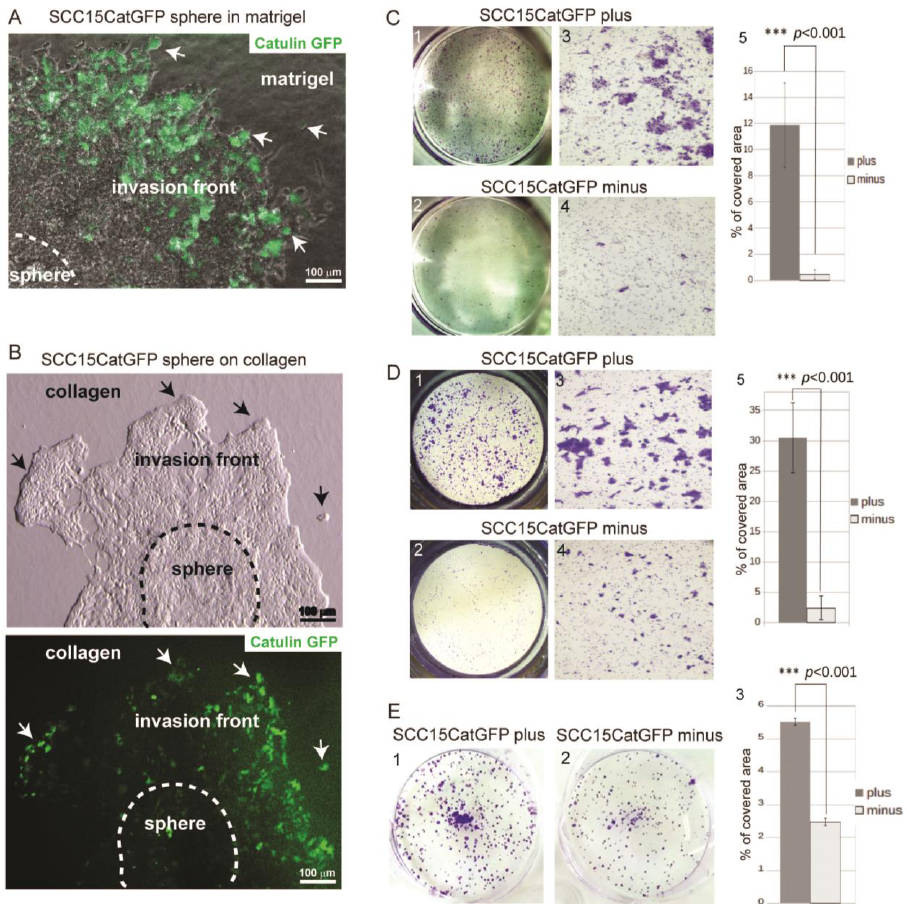
Figure 2. Migratory, invasive, and tumorigenic potential of the cells labeled with Catulin-GFP reporter system in vitro. ( A ) Sphere formed by SCC15CatGFP cells invading into Matrigel presented in a bright field and GFP fluorescence. Arrows indicate cells with the highest alpha-catulin (GFP fluorescence) expression at the invasion front. Scale bar: 100 µm. ( B ) Sphere formed by SCC15CatGFP cells placed on collagen presented in a bright field ( upper picture ) and GFP fluorescence ( lower picture ). Arrows indicate cells with the highest alpha-catulin (GFP fluorescence) expression at the invasion front. Scale bar: 100 µm. ( C ) Boyden chamber migration assays of the SCC15CatGFP plus and SCC15CatGFP minus populations. ( 1 , 2 ) Image of the entire insert. ( 3 , 4 ) Image of a randomly selected area at a higher magnification (4×). Cells were stained with crystal violet. ( 5 ) Quantification of the cells from both populations that migrated through the insert. *** statistical significance was assessed by t-test ( p < 0.001). Standard error bars are shown. ( D ) Boyden chamber Matrigel invasion assays of the SCC15CatGFP plus and SCC15CatGFP minus populations. ( 1 , 2 ) Image of the entire insert. ( 3 , 4 ) Image of a randomly selected area at a higher magnification (4×). Cells were stained with crystal violet. ( 5 ) Quantification of cells from both population that invaded through the insert covered with Matrigel. *** statistical significance was assessed by t-test ( p < 0.001). Standard error bars are shown. ( E ) Colony formation assays of the SCC15CatGFP plus ( 1 ) and SCC15CatGFP minus ( 2 ) populations. An equal number of cells of both populations were plated in duplicates into six-well plates. Cells were stained with crystal violet. ( 3 )